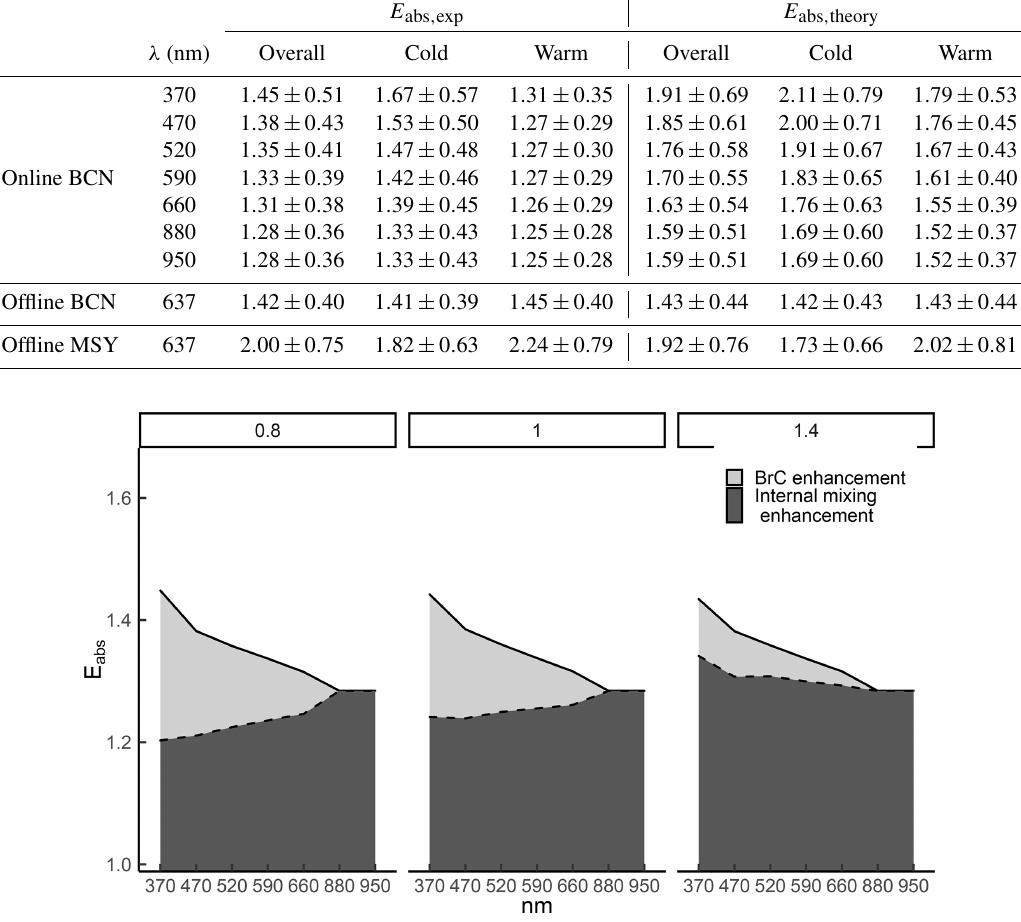
Figure 2. Absorption enhancement ( E abs ) attribution to both internal and external mixing under different AAE conditions for the internally mixed BC (0.8, 1, 1.4) for the online measurements at the 7-AE33 wavelengths at Barcelona